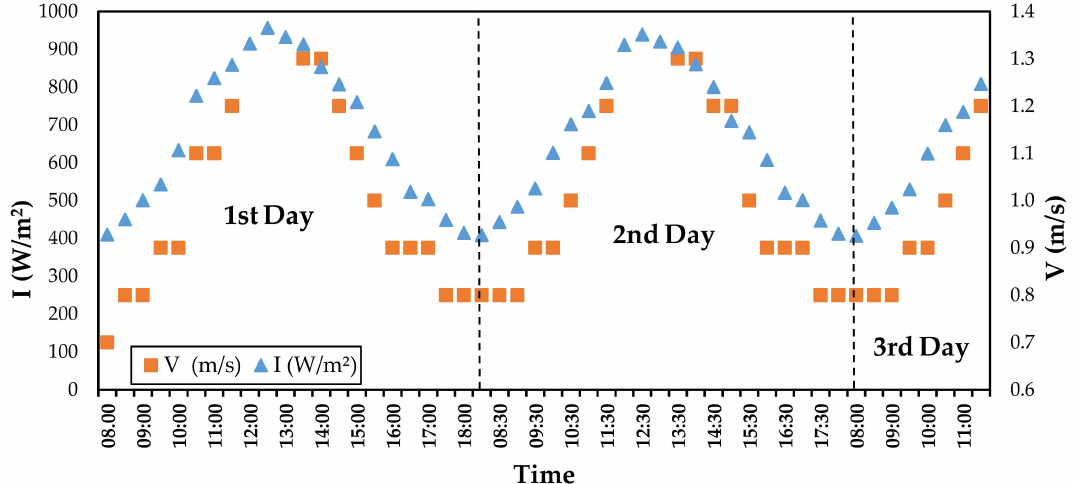
Figure 8. Variation of solar radiation ( I ) and air velocity ( V ) values with time.